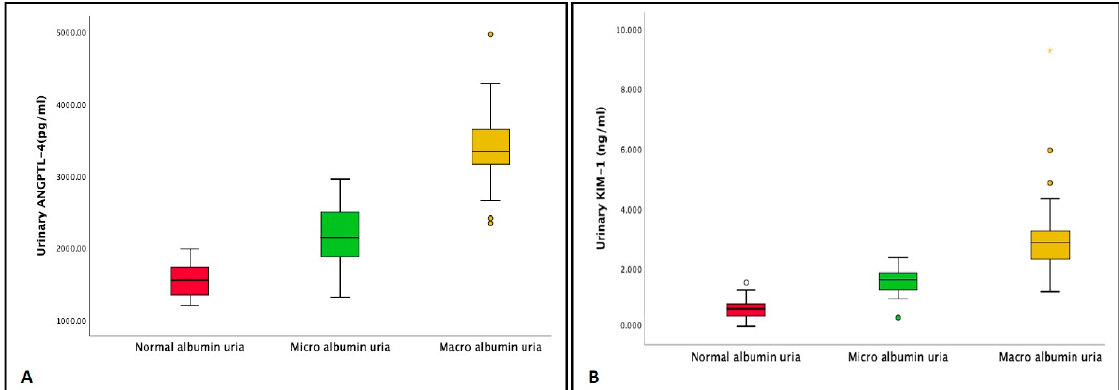
Figure 2. Urinary levels of the biomarkers ( A ) ANGPTL-4 and ( B ) KIM-1 in the patients groups classified according to urinary albumin–creatinine ratio (UACR) levels; normoalbuminuria UACR < 30 mg/g, microalbuminuria UACR 30 to 300 mg/g, and macroalbuminuria UACR > 300 mg/g.